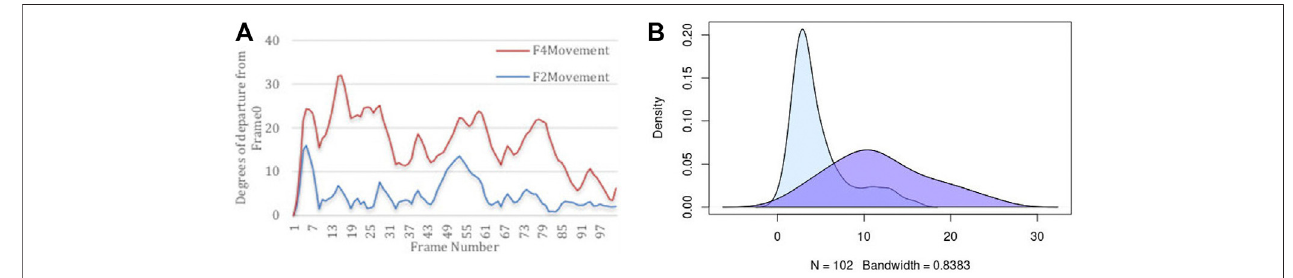
FIGURE5| Descriptivestatisticsdescribing (A) theangulardeparturefromtheinitialstate(Frame0)forbothRigid-Bodydomains,and (B) thedistributionofangular departure to assess the amount of time spent in each state.